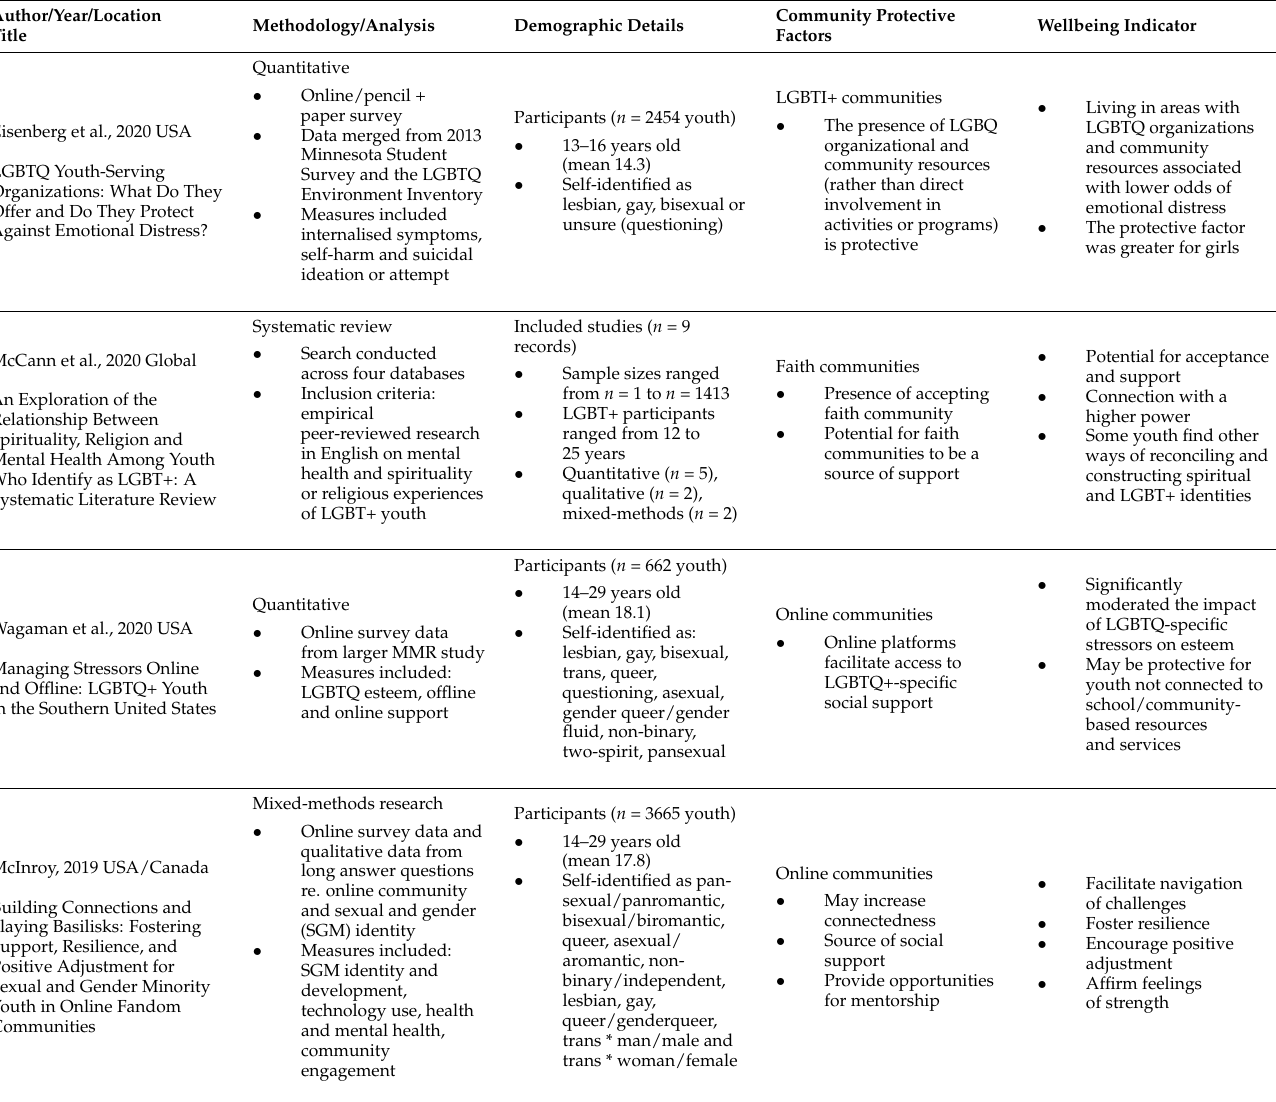
Table 4. Quantitative, mixed-methods research and systematic review of records of community protective factors for LGBTI+ youth wellbeing: LGBTI+, online, faith and cultural communities ( n =